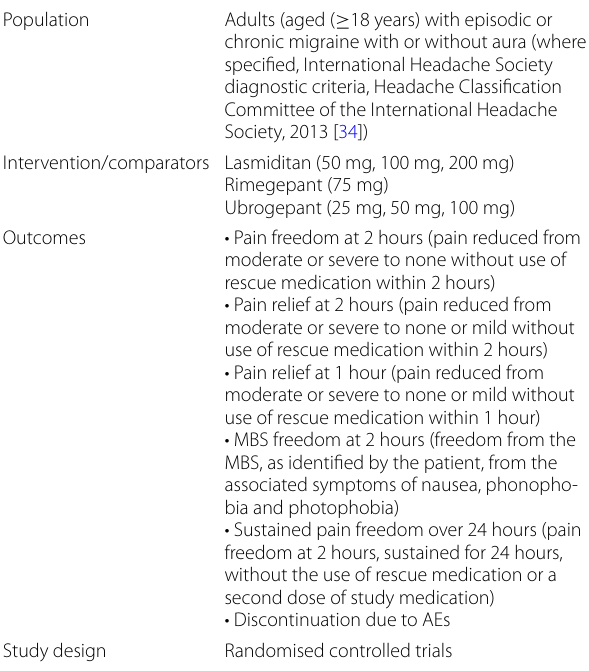
Table 1 Population, intervention, comparator and outcome selection (PICOS)